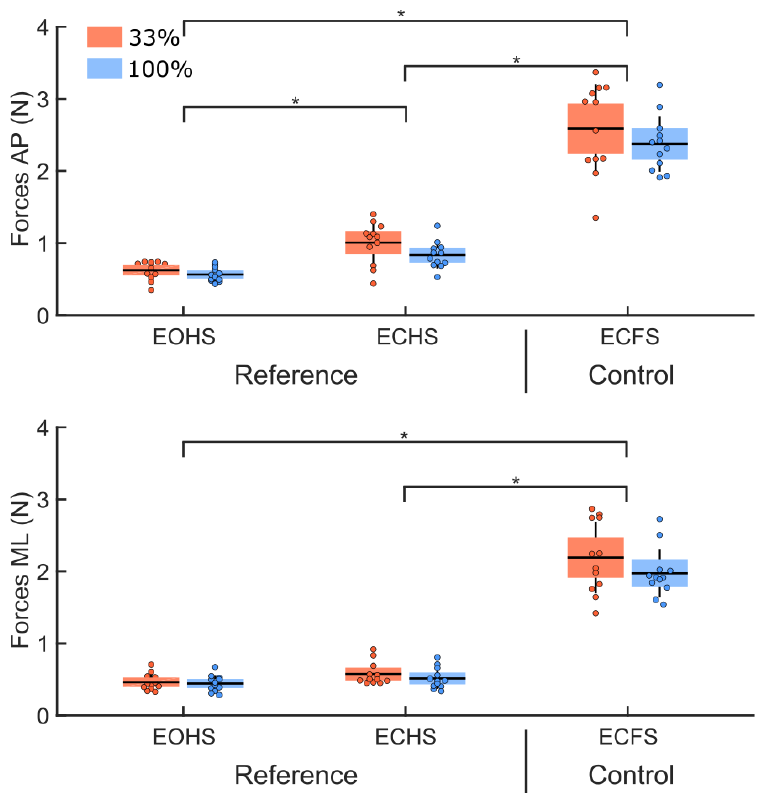
Figure 6. RMS values of the ground reaction forces along the AP (upper panel) and ML (lower panel) axes for both groups (33% and 100% feedback groups, red and blue boxes, respectively). Means are for the reference condition (EOHS and ECHS) and for the control condition (ECFS). The dots represent mean results for each participant, horizontal lines depict the group’s means, boxes represent the group’s standard error of the mean, and vertical lines, one standard deviation. The asterisks (*) indicate significant differences between conditions.